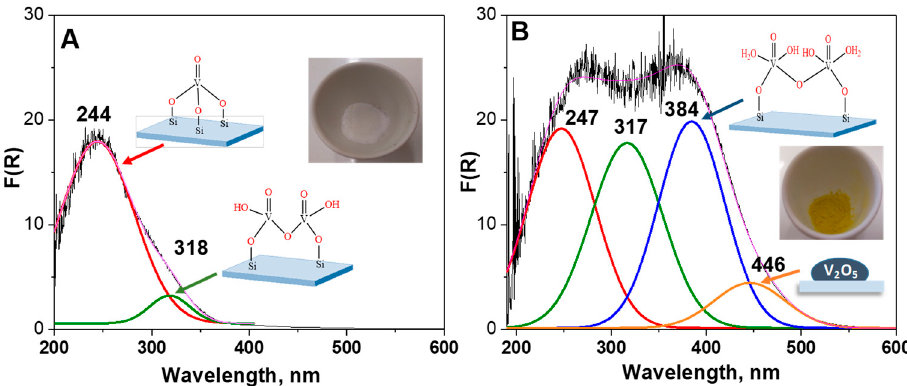
Figure 3. UV-Vis spectra of V M /SBA-15 sample: ( A ) dehydrated sample; ( B ) hydrated sample. Figure 4 presents the ESR spectra of V M /SBA-15 and TPS/V M /SBA-15. The ESR signal from V 4+ in V M /SBA-15 material, after the treatment with TPS, became twice as small as the original one, which confirms the oxidation of vanadium by TPS species.